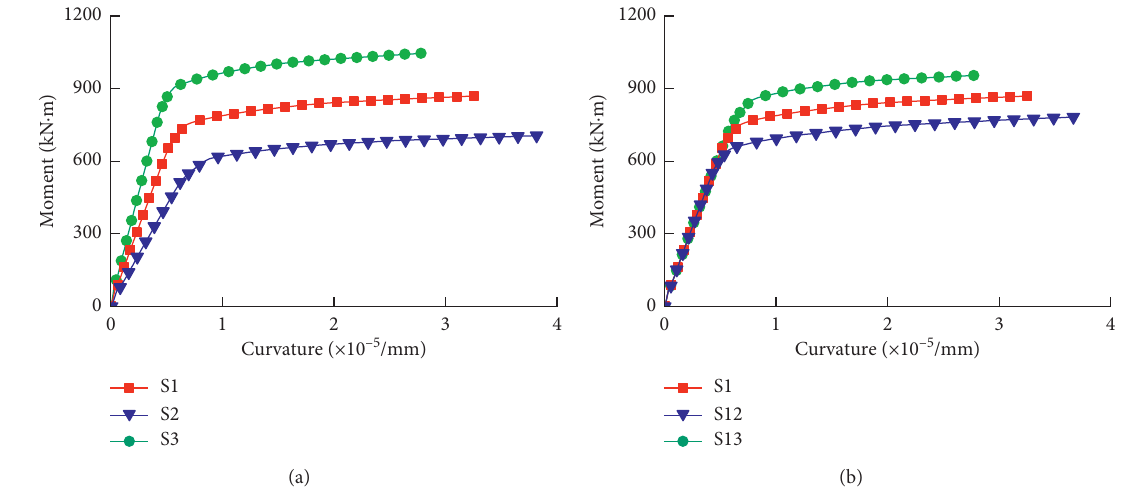
Figure 16: Typical moment-curvature curves. (a) Effect of CSW depth. (b) Effect of yield strength of steel